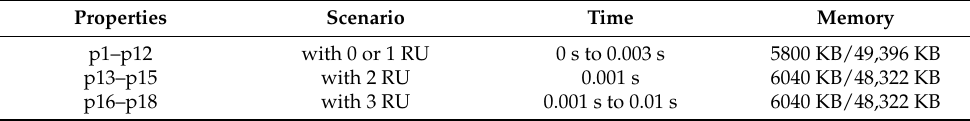
Table 4. Properties verified with UPPAAL —Execution results.